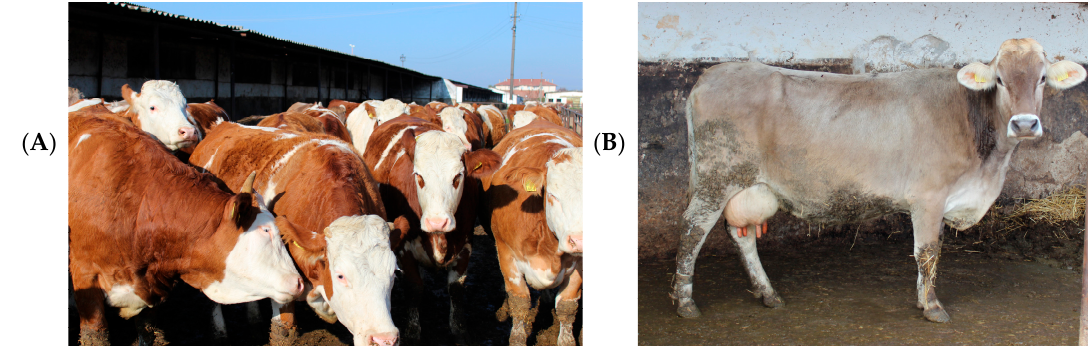
Figure 1. ( A ) Romanian Spotted breed; ( B ) Romanian Brown breed.